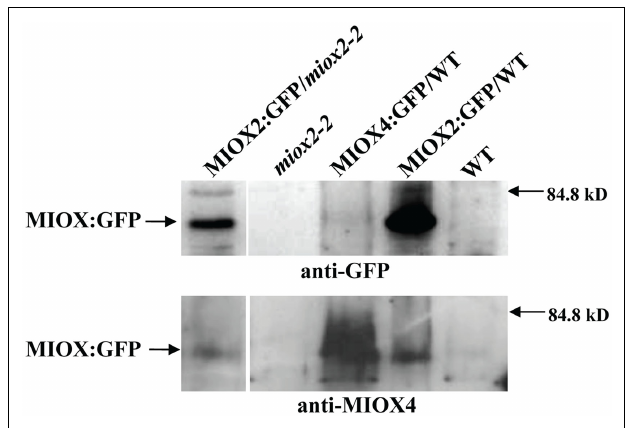
FIGURE 4 | Expression of MIOX4: and MIOX2:GFP in transgenic seedlings. Denatured protein extracts from seedlings were separated by SDS-PAGE, transferred to nitrocellulose, and blotted with either an anti-GFP or anti-MIOX4